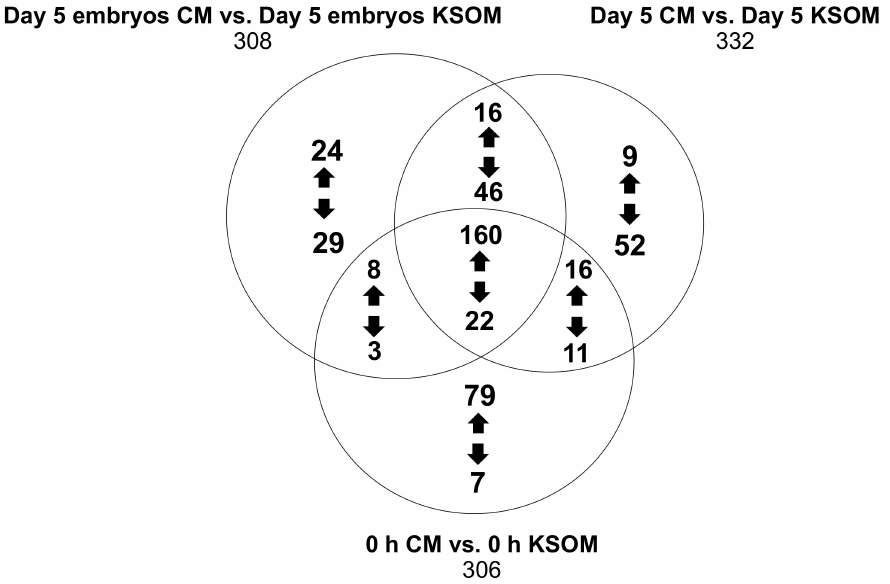
Figure 6. Venn diagram showing the distribution of the number of metabolites between the three pairwise